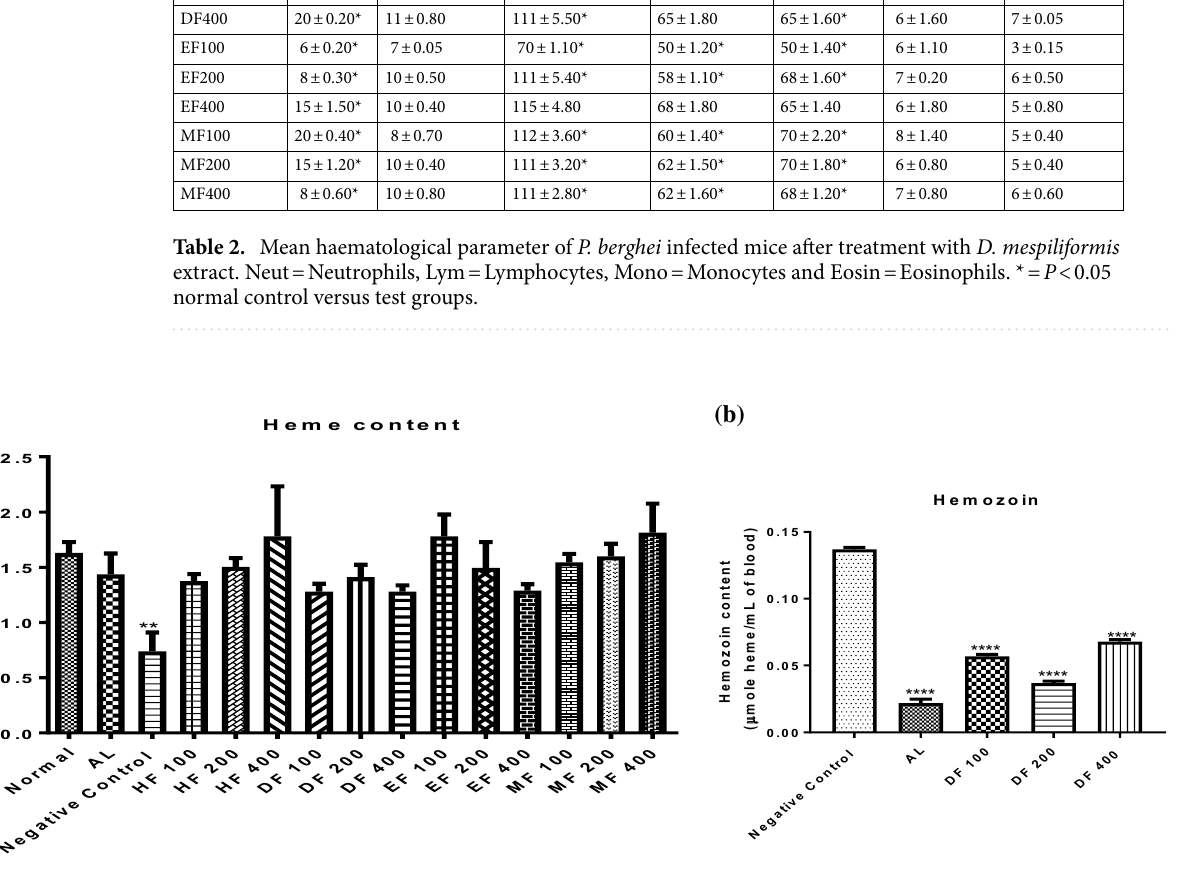
the negative control was the least (6%) while the PCV value for the DF group at 200 and 400 mg/kg were 25 and 20%, respectively. This is significantly ( P < 0.05) higher than the untreated control. Interestingly, this mean PCV values of drug control (AL) and 200 mg DF/kg were not significantly different ( P < 0.05) from the PCV value obtained from the normal group that were neither infected nor treated as shown in Table 2. Similar results were obtained for platelet counts except that 400 mg EF/kg platelet value was not significantly different from the nor- mal control value. The WBC values however, were not significantly ( P > 0.05) different when compared across the groups. Comparing the neutrophil count between the normal control and the test groups, we discovered that this blood cell value in the normal control were not significantly different ( P > 0.05) when compared with AL and DF doses at 200 and 400 mg/kg, as well as EF at 400 mg/kg. Furthermore, the lymphocyte count of the normal control is significantly different from all test groups except 400 mg EF/kg, while both monocyte and eosinophil counts were not significantly different among the groups (Table 2).